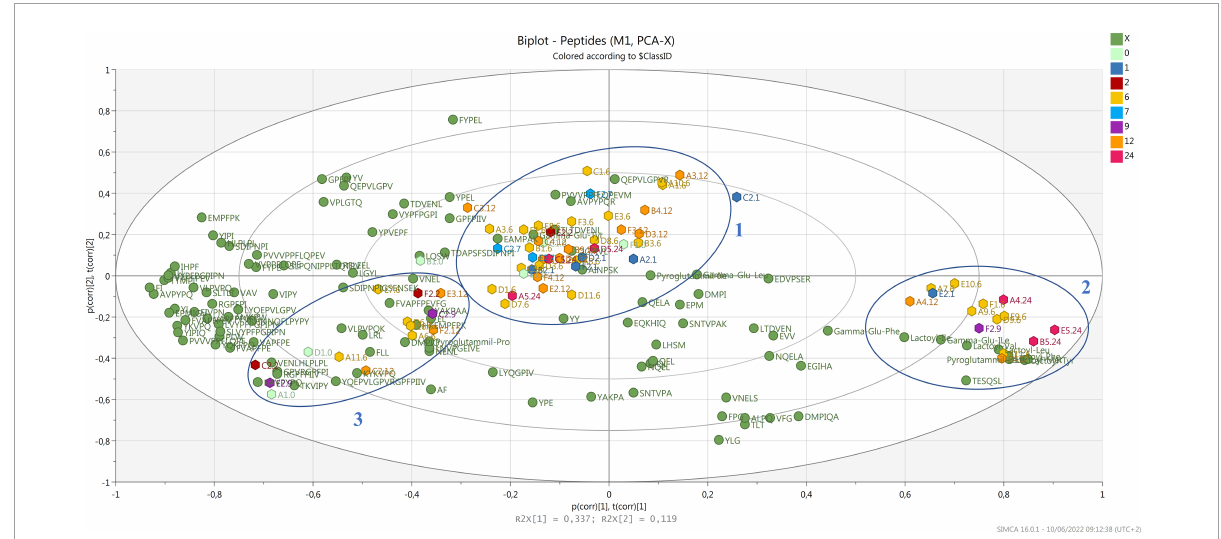
FIGURE2 Biplot of samples (hexagons) and all detected peptides (green dots). Samples are colored by ripening